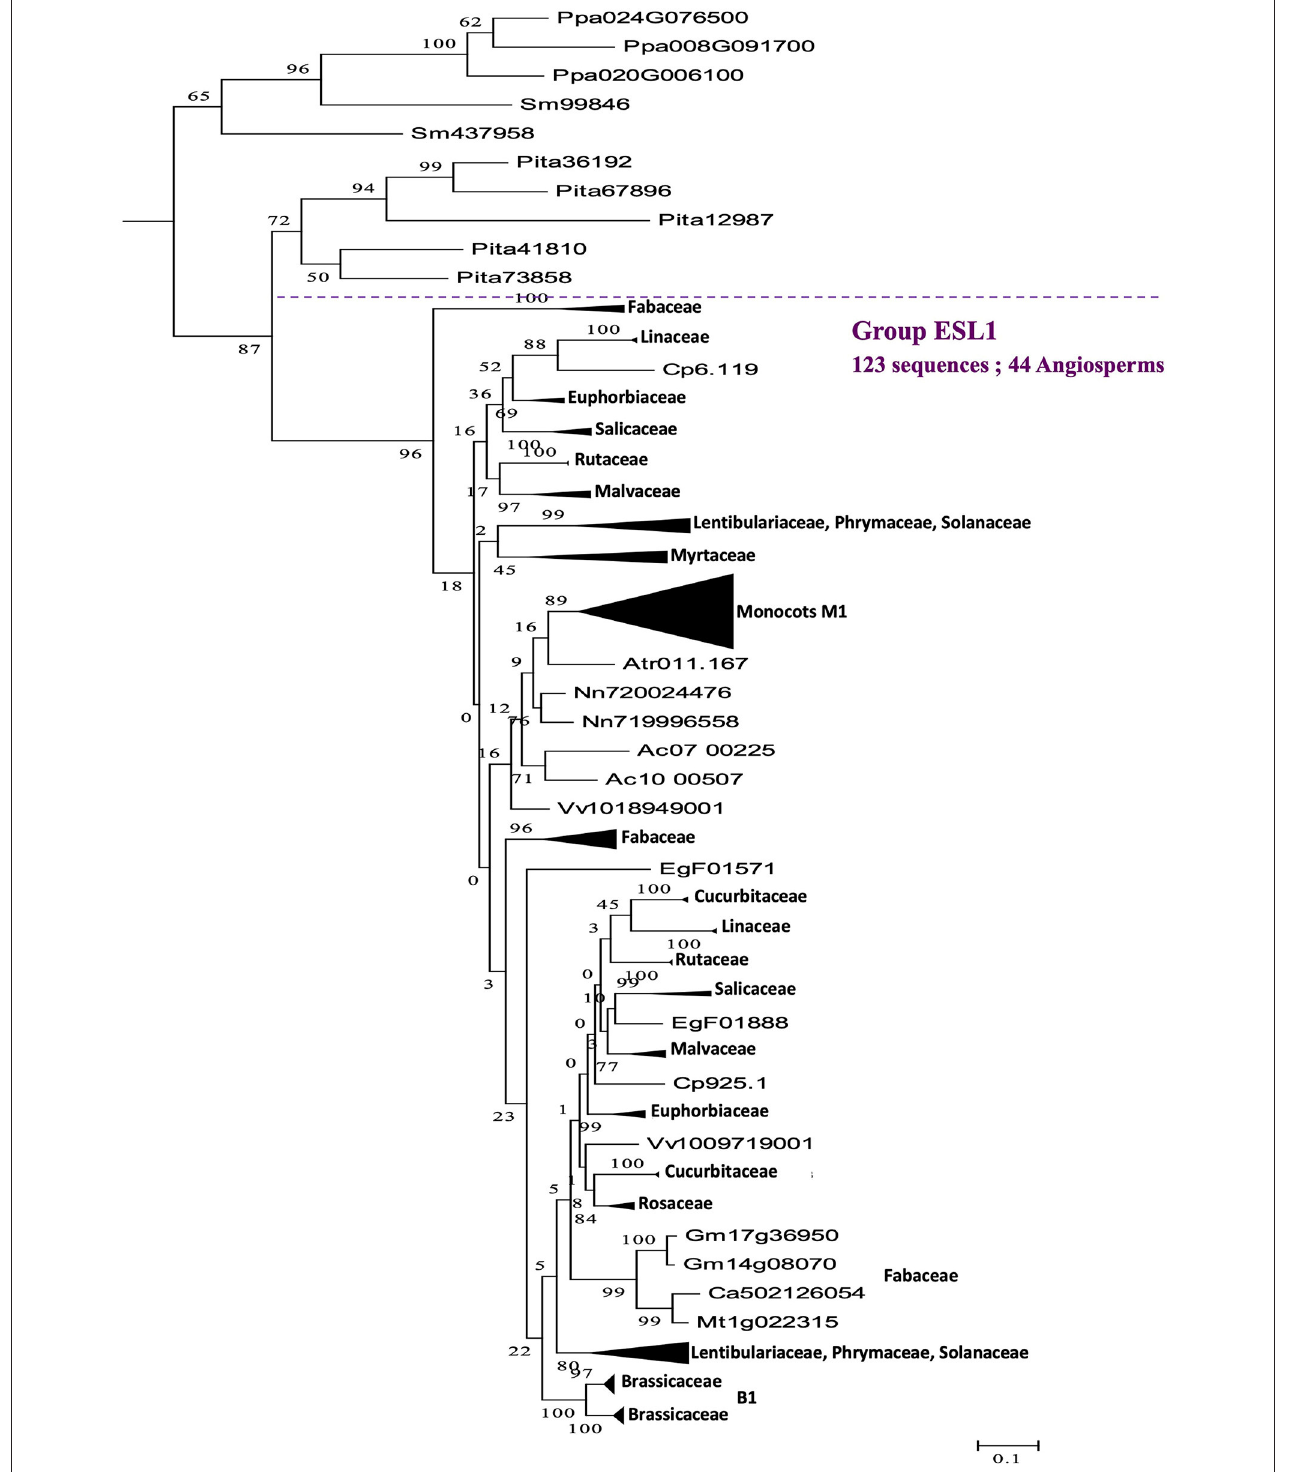
FIGURE 3 | The maximum likelihood phylogeny of ESL sugar transporter proteins: The details of group ESL1. The tree was produced by aligning 519 amino acid ESL sequences identified in 47 Embryophyta using ClustalW and was then built using the software Molecular Evolutionary Genetics Analysis (MEGAv6, Tamura et al., 2013). JTT amino acid substitution model was used and the bootstrap consensus tree was inferred from 1,000 replicates. The percentage of replicate trees in which the associated taxa clustered together in the bootstrap test is shown next to the branches. The tree is drawn to scale, with branch lengths measured in the number of substitutions per site. For the annotation of sequences, see Supplementary Table 1